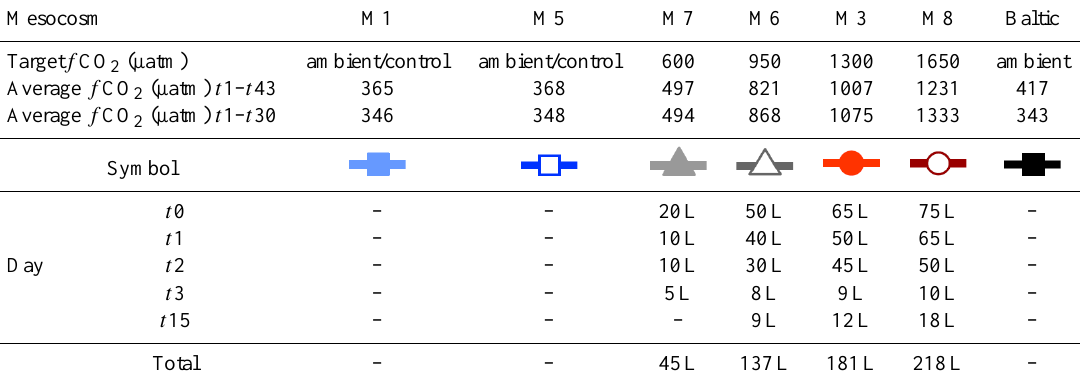
Symbols and colours indicated here are used in all following figures.